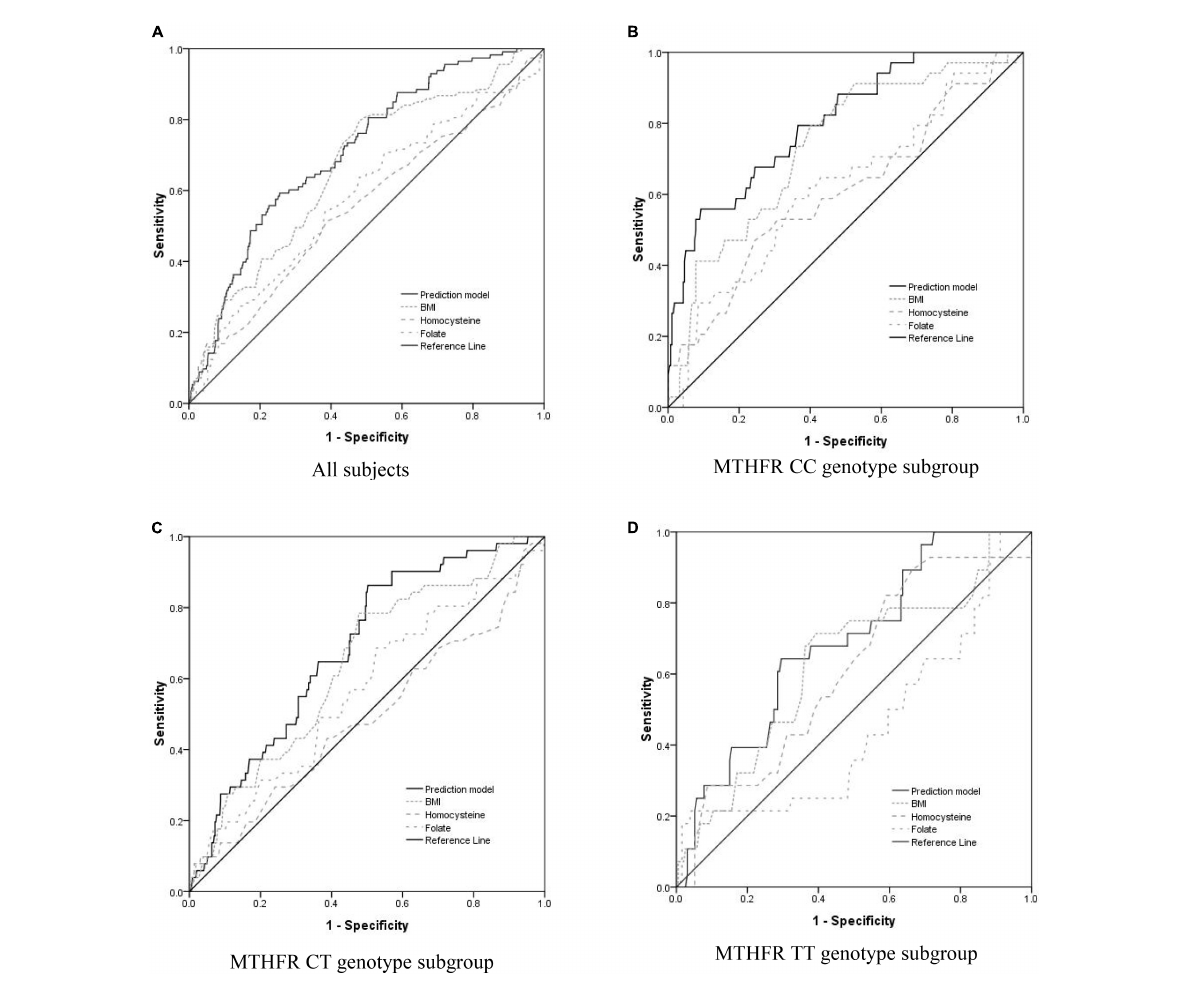
FIGURE1 Evaluate the accuracy of the PIH prediction model including BMI and serum concentration of folate and homocysteine using receiver operating characteristic (ROC) curve analysis. (A) For All of the subjects, the area under the curve (AUC) of the prediction model, BMI, serum homocysteine concentration, and serum folate concentration was 0.711 (95% CI = 0.663–0.758, p < 0.0001), 0.664 (95% CI = 0.611–0.716, p < 0.0001), 0.554 (95% CI = 0.494–0.615, p = 0.059), and 0.580 (95% CI = 0.521–0.639, p = 0.006), respectively. (B) For the subgroup of subjects with MTHFR CC genotype, the AUC of the prediction model, BMI, serum homocysteine concentration, and serum folate concentration was 0.802 (95% CI = 0.725–0.878, p < 0.0001), 0.737 (95% CI = 0.652–0.821, p < 0.0001), 0.606 (95% CI = 0.498–0.713, p = 0.044), and 0.617 (95% CI = 0.513–0.720, p = 0.026), respectively. (C) For the subgroup of subjects with MTHFR CT genotype, the AUC of the prediction model, BMI, serum homocysteine concentration, and serum folate concentration was 0.684 (95% CI = 0.615–0.754, p < 0.0001), 0.638 (95% CI = 0.562–0.715, p = 0.001), 0.489 (95% CI = 0.398–0.579, p = 0.792), and 0.565 (95% CI = 0.479–0.651, p = 0.127), respectively. (D) For the subgroup of subjects with MTHFR TT genotype, the AUC of the prediction model, BMI, serum homocysteine concentration, and serum folate concentration was 0.685 (95% CI = 0.587–0.783, p = 0.002), 0.628 (95% CI = 0.514–0.742, p = 0.001), 0.609 (95% CI = 0.500–0.717, p = 0.063), and 0.449 (95% CI = 0.326–0.651, p = 0.573),